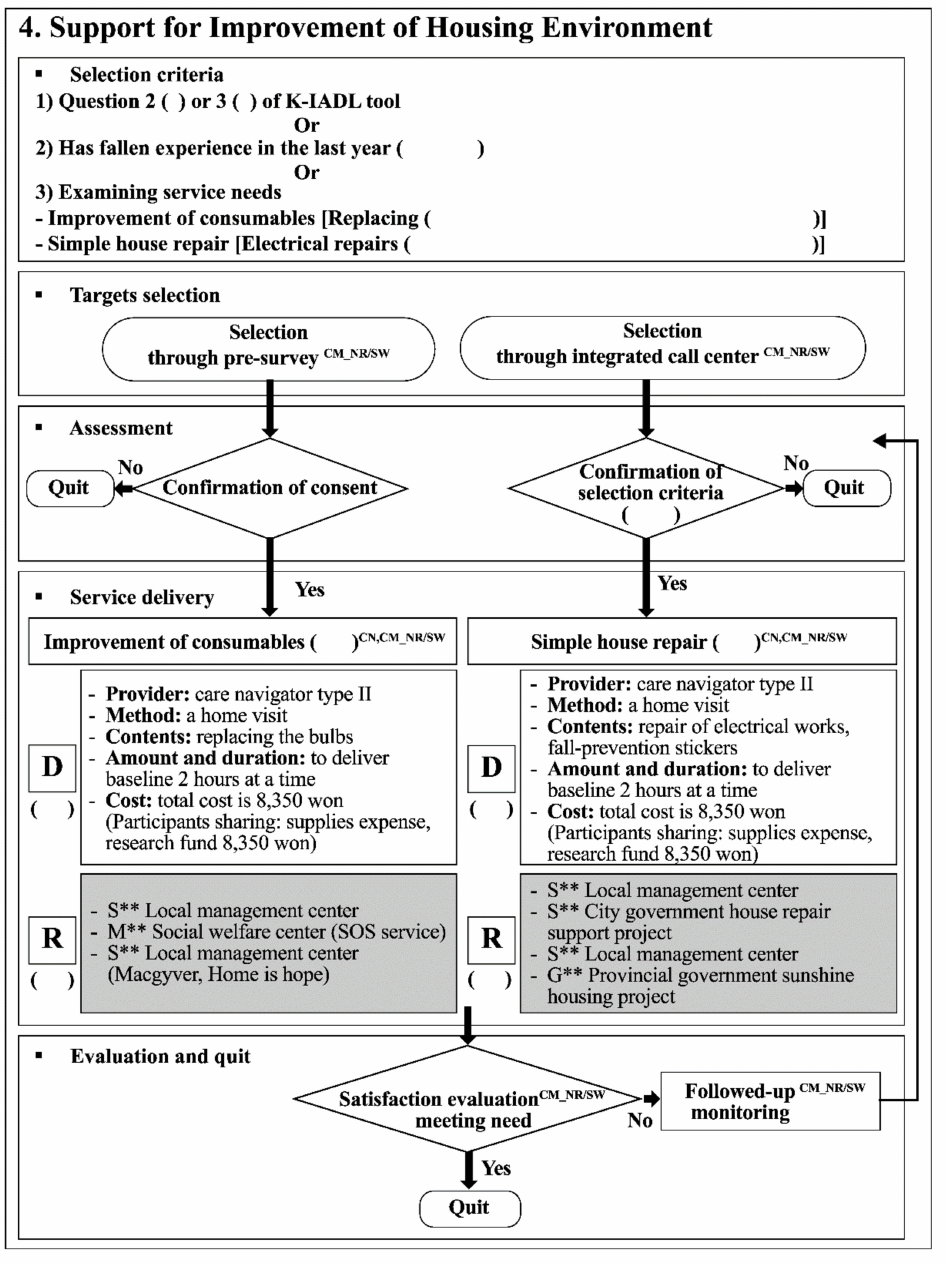
Figure 2. Example of an algorithm. K-IADL: Korean instrumental activities of daily living scale; GM: general manager; CM: care manager; NR: nurse; SW: social worker; CN: care navigator; D: direct service provider; R: reference to existing service; Won: unit of Korean currency, 8350 won is about 7 U.S.